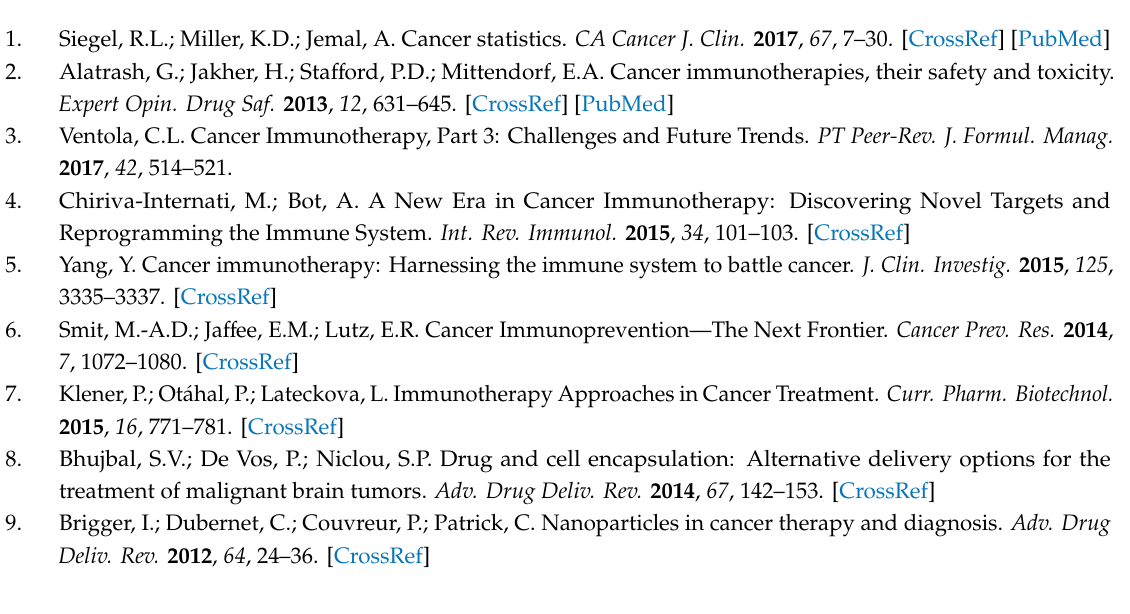
Figure S1: SEM of the cross section of the heat sealed electrospun PSF MTAM which revealed no openings, forming a continuous seal on the micron / sub-micron scale; Figure S2: In vitro culture of MDA-MB-468 (top) and PC 3 (bottom) in TCPs and PSF MTAMs. Both culture substrates revealed an increasing viability across time; Figure S3: Immunohistochemistry staining of the respective cancer cells; MDA-MB-468 (top) and PC 3 (bottom). Clearly, PC-3 revealed no immunofluorescence signal when targeted fluorescent antibodies targeting CEACAM 6 were